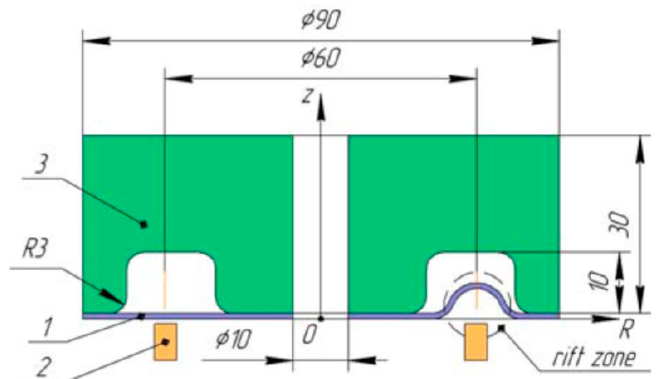
Figure 39. Schematic diagram of free electromagnetic forming: 1—workpiece, 2—coil, 3—die (re ‐ printed with permission from [127]; copyright© 2021, KSAE/112 ‐ 11).